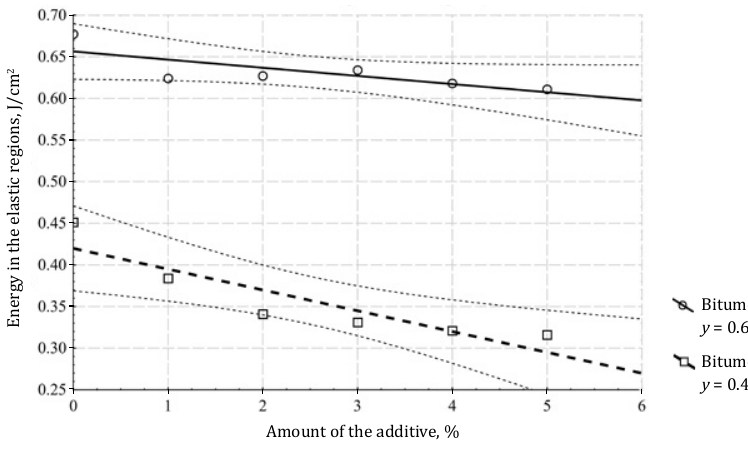
Figure 8b. Conventional energy in the elastic regions in the force ductility